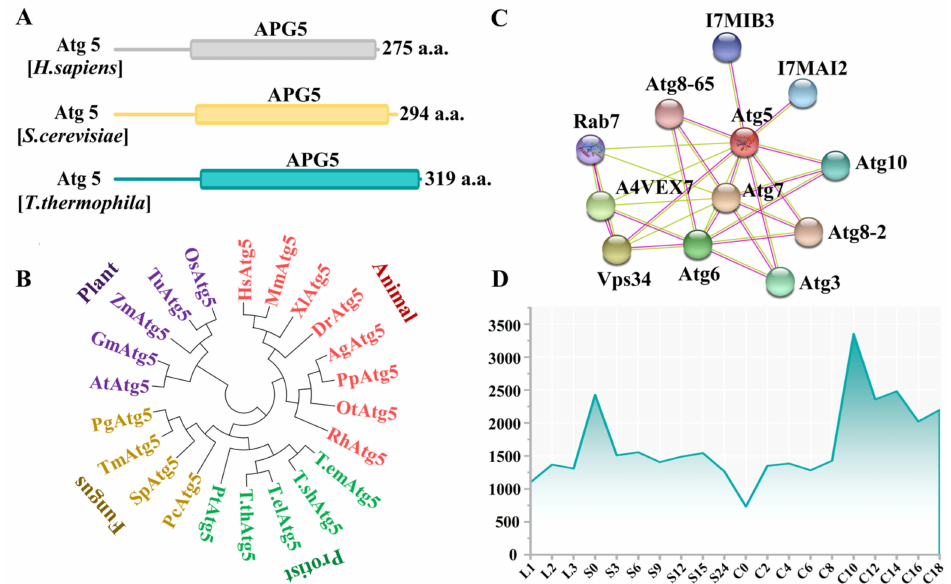
Figure 1. Characterization of Atg5 in Tetrahymena thermophila. ( A ) Schematic of the functional domain of the autophagy-related protein Atg5. Analysis was performed in the SMART database; ( B ) Phyloge- netic tree of Atg5. Phylogenetic trees were constructed based on the amino acid sequences of APG5 domain from different species. HsAtg5, Homo sapiens Atg5 (AGC52703.1); MmAtg5, Mus musculus